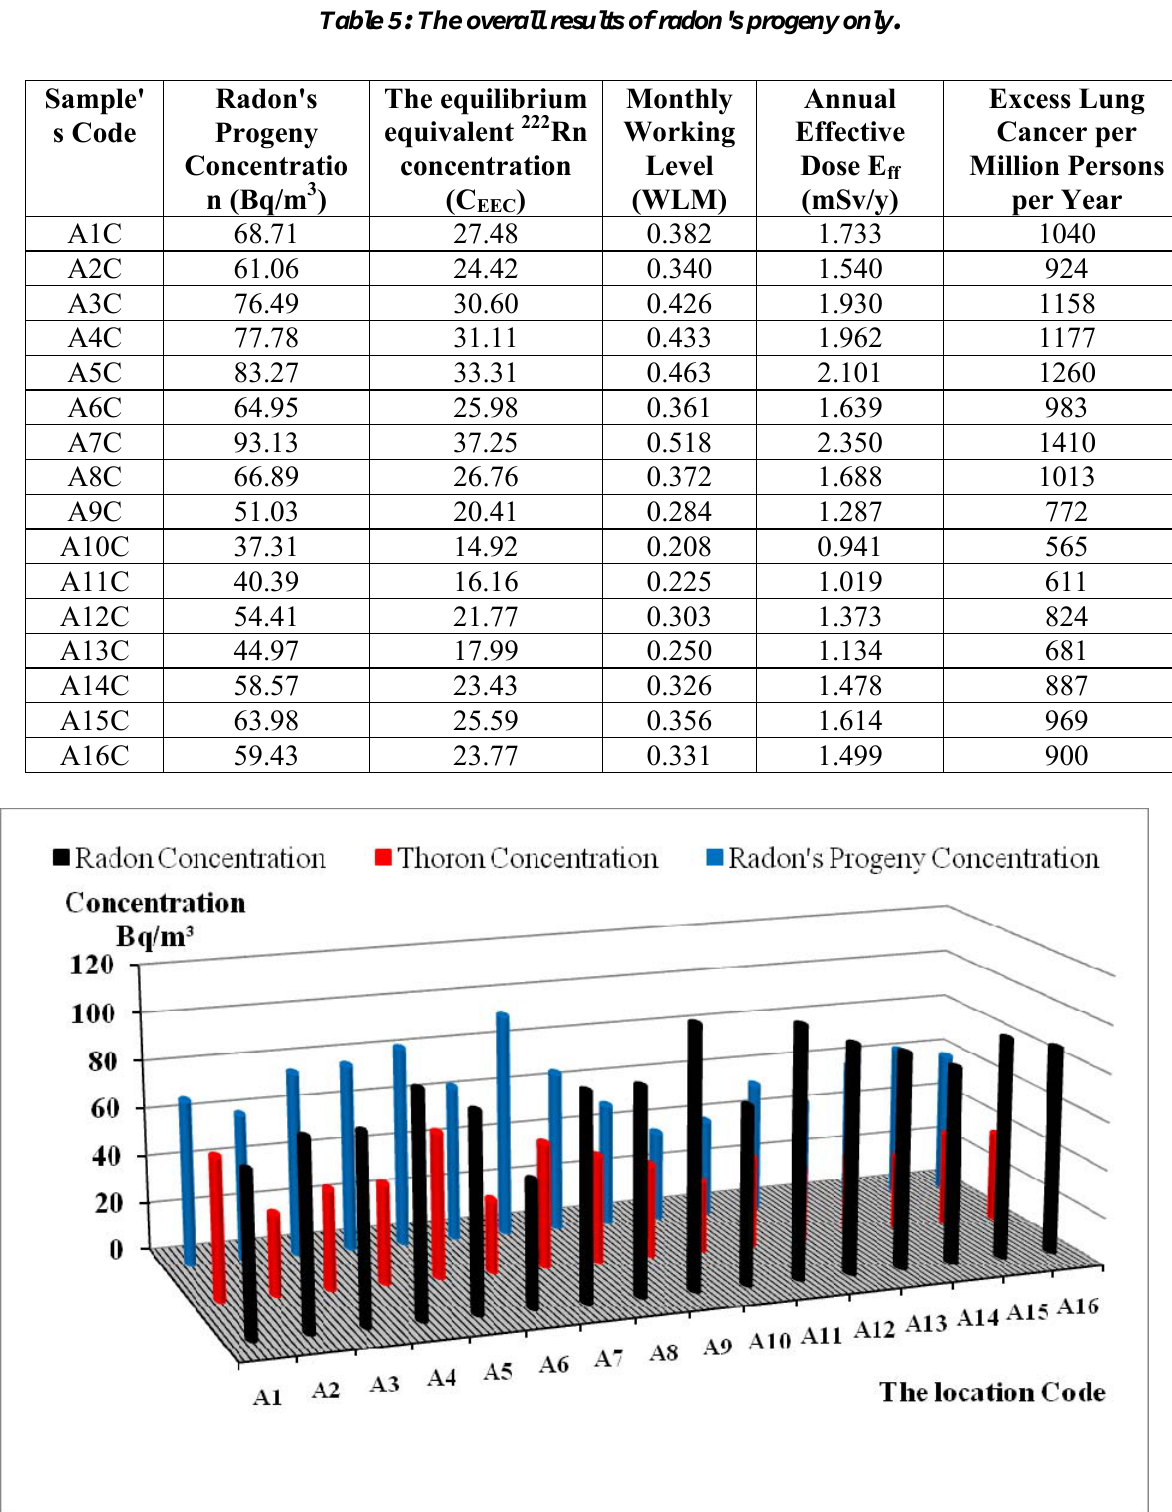
Fig. 6: The concentration of; radon(black), thoron (red), and radon's progeny (blue) at the measured